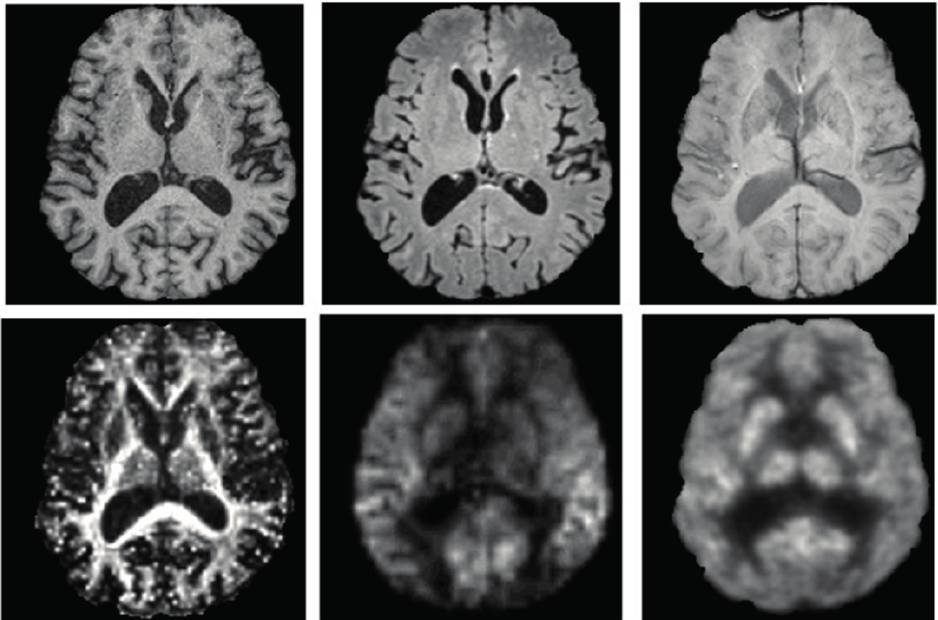
Figure 2. PET and MR images of a 77-year-old male injected with 198 MBq of 18 F-flurodeoxyglucose (FDG) while patient was lying supine in a Siemens Biograph mMR PET-MR hybrid scanner (Siemens Healthcare, Erlangen, Germany). A 60 min dynamic PET scan was acquired during multispectral MR imaging. These images illustrate the capacity to perform multi-parametric mapping in a single session simultaneously, to improve characterization of neuropsychiatric conditions. Axial images are from ( top ) left to right: T1-weighted (MRPAGE) for tissue-specific volumetric measurements, T2-weighted (FLAIR) for assessment of white matter lesions, and susceptibility-weighted imaging for detection of microbleeds and cerebral amyloid angiopathy; ( bottom ) left to right: fractional anisotropy image from diffusion tensor imaging for quantification of white matter structural integrity, perfusion weighted-imaging (ASL) for hemodynamic measurements and a PET- 18 F-FDG glucose consumption image. Images are presented with permission from patient and are courtesy of Lawson imaging, Lawson Health Research Institute (LHRI), London, ON,